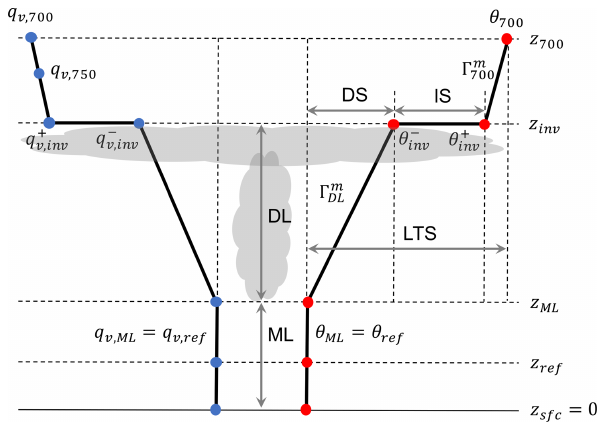
Figure 1. Schematic diagram illustrating an idealized structure of the decoupled planetary boundary layer (PBL), which consists of a surface-based mixed layer (ML) topped by z ML with the po- tential temperature, θ ML = θ ref , and water vapor specific humidity, q v , ML = q v , ref , given at the reference height, z ref ; a decoupled layer (DL) in which the vertical temperature gradient is assumed to fol- low a saturated moist adiabat at the ML top ( (cid:48) m ); an inversion at DL z inv across which θ increases and q v decreases in a discontinuous way; and the free atmosphere between z inv and z 700 in which the vertical temperature gradient is assumed to follow a saturated moist adiabat at the 700hPa level ( (cid:48) m ). Also shown are the inversion 700 − θ − − θ ML ; strength, IS ≡ θ + ; decoupling strength, DS ≡ θ − inv inv inv and lower-tropospheric stability (LTS) ≡ θ 700 − θ ML . The lapse rate of q v in the free atmosphere is given by the linear slope between q v, 700 and q v, 750 . For simplicity, it is assumed that θ and q v share − θ ML )/(θ + − θ ML ) = a common decoupling parameter, α ≡ (θ − inv inv − q v , ML )/(q + − q v , ML ) . Over the ocean, stratocumulus (q − v , inv v , inv generally exists below the inversion base and shallow cumulus grows into the overlying stratocumulus in the decoupled layer. See the text for more